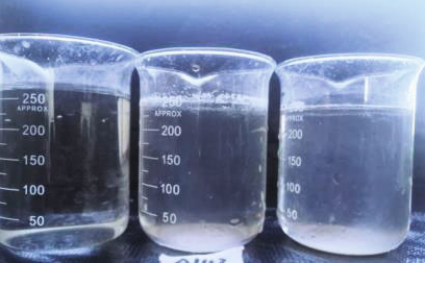
Figure 8: Fragment test. Table 3: Empirical values of